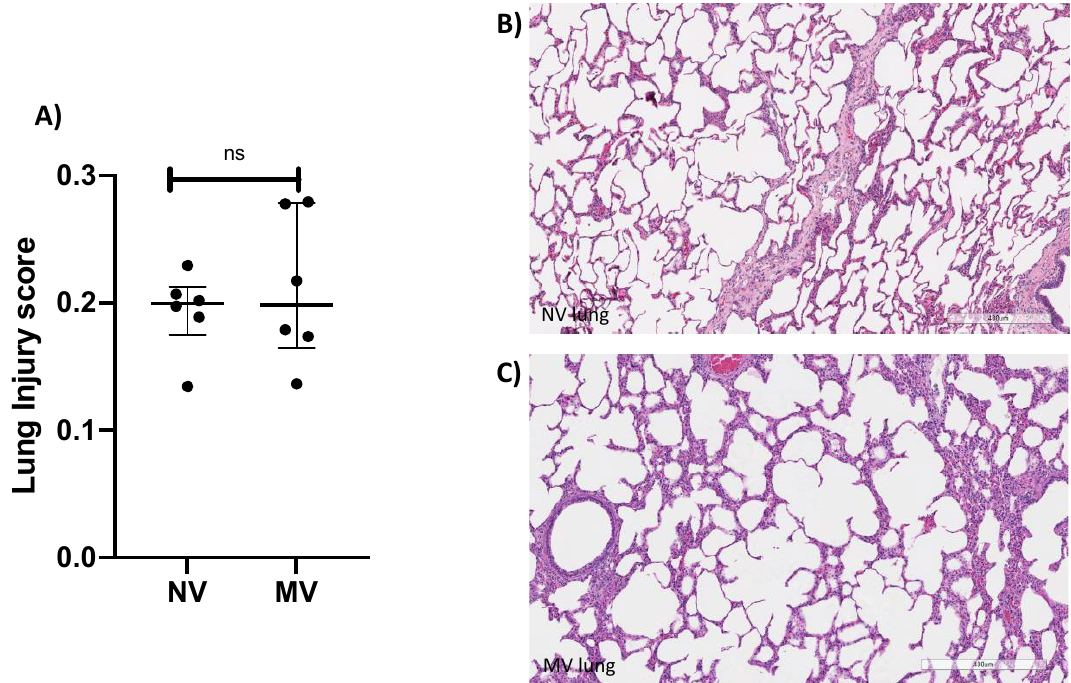
Figure 8. ( A ) Dot plot showing the lung injury scores of the NV group (0.19; 0.17–0.21) and the lung injury scores of the MV group (0.19; 0.16–0.27) with no statistical difference between the groups, p = 0.8182. Lung histology slides stained by hematoxylin and eosin, NV subject ( B ) and MV subject ( C